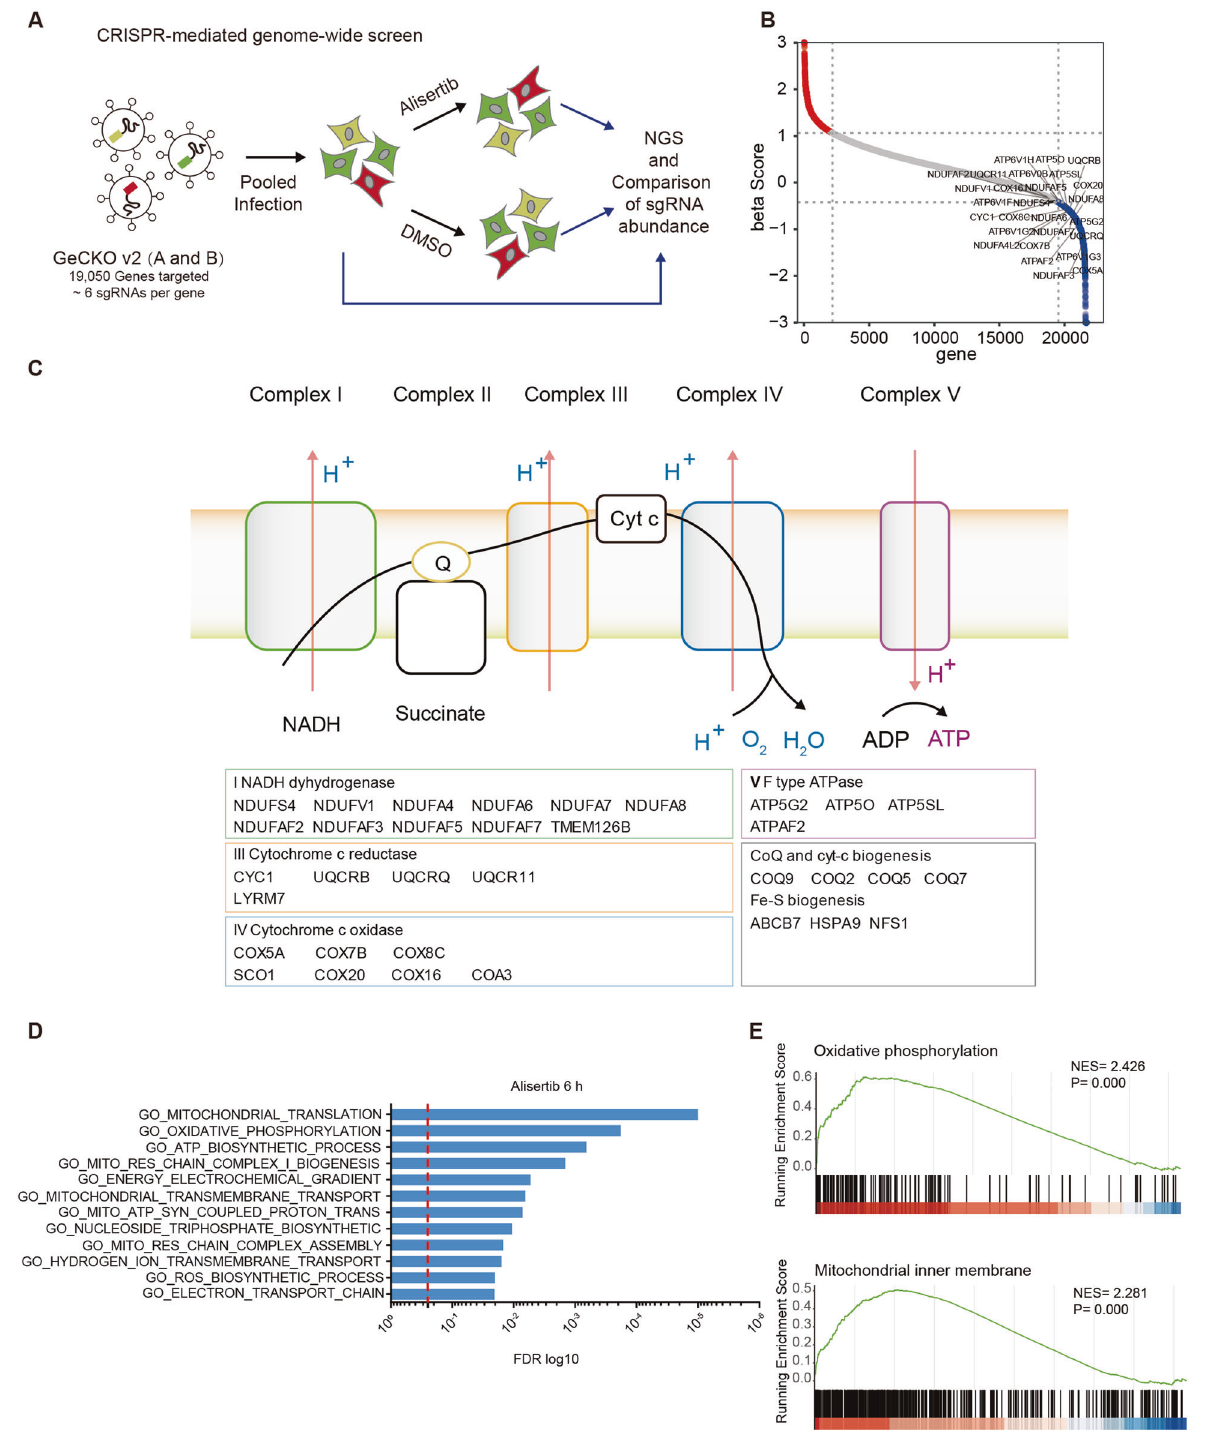
Fig. 1 CRISPR/Cas9-based genome-wide screen reveals cellular OXPHOS-dependence upon alisertib treatment. A Schematic for genetic knockout screening to identify synergistic targets of alisertib in MDA-MB-231 cells. B Plot showing the distribution of CRISPR beta scores (treatment vs pretreatment) for genes targeted by the sgRNA library. Blue dots are the top 3000 negative enrichment genes. OXPHOS associated genes are highlighted. C KEGG showing signi fi cant enrichment of the OXPHOS pathway in the top 3000 negative enrichment genes. D GSEA analysis showing signi fi cant enrichment of OXPHOS and mitochondria respiration in the gene set that are induced upon 6 h alisertib treatment. E Enrichment graph of GO_Oxidative phosphorylation (NES = 2.426, p = 0) and GO_Mitochondrial inner membrane (NES = 2.345, p = 0). See also Fig.